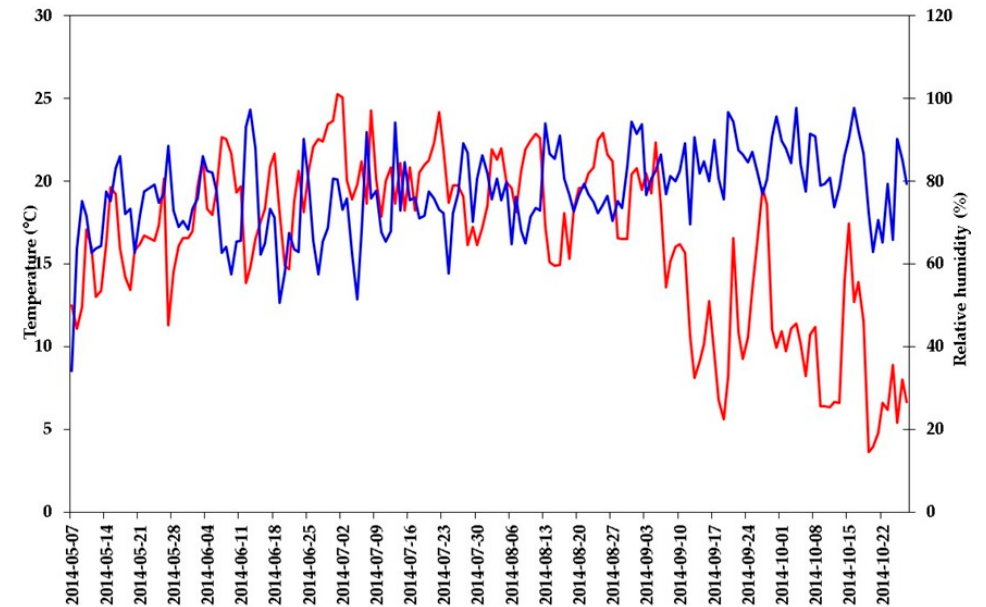
Figure 2. Variations in the relative humidity of the air (blue) and in the average air temperature (red) inside the tunnel during the first growing season of white spruce seedlings (1 + 0).